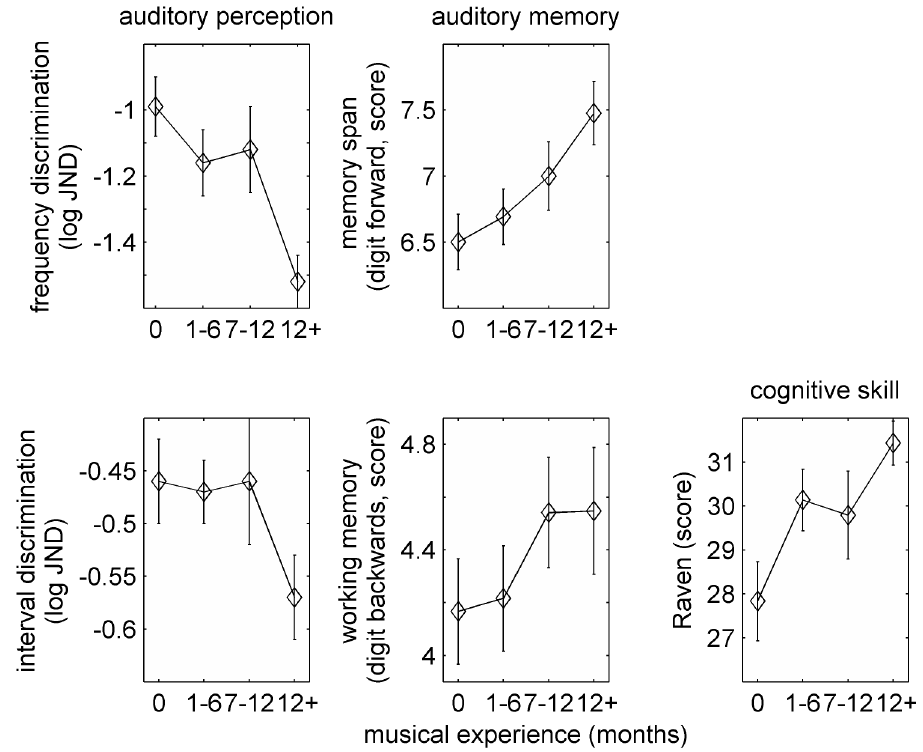
Figure 1. Auditory perception (frequency and interval discrimination), verbal memory (Digit forward and Digit Backward) and reasoning ability (Raven’s matrices) as a function of musical experience, in months of formal training. Error bars are ± 1 standard error of the mean. doi: